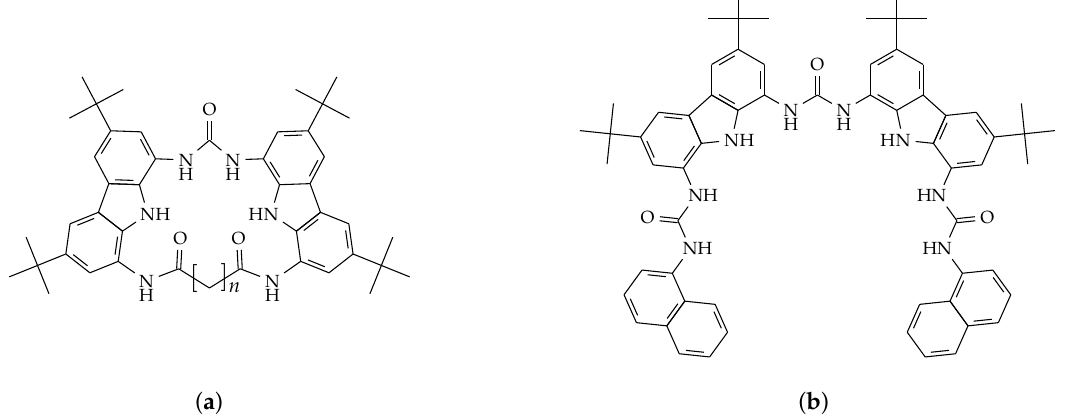
Figure 1. The ionophores included in this study: ( a ) macrocyclic receptors where n = 5, 9, or 12 (MC5, MC9, and MC12, respectively), and ( b ) an acyclic receptor (AC). See Table A1 for binding constants determined for some carboxylates.